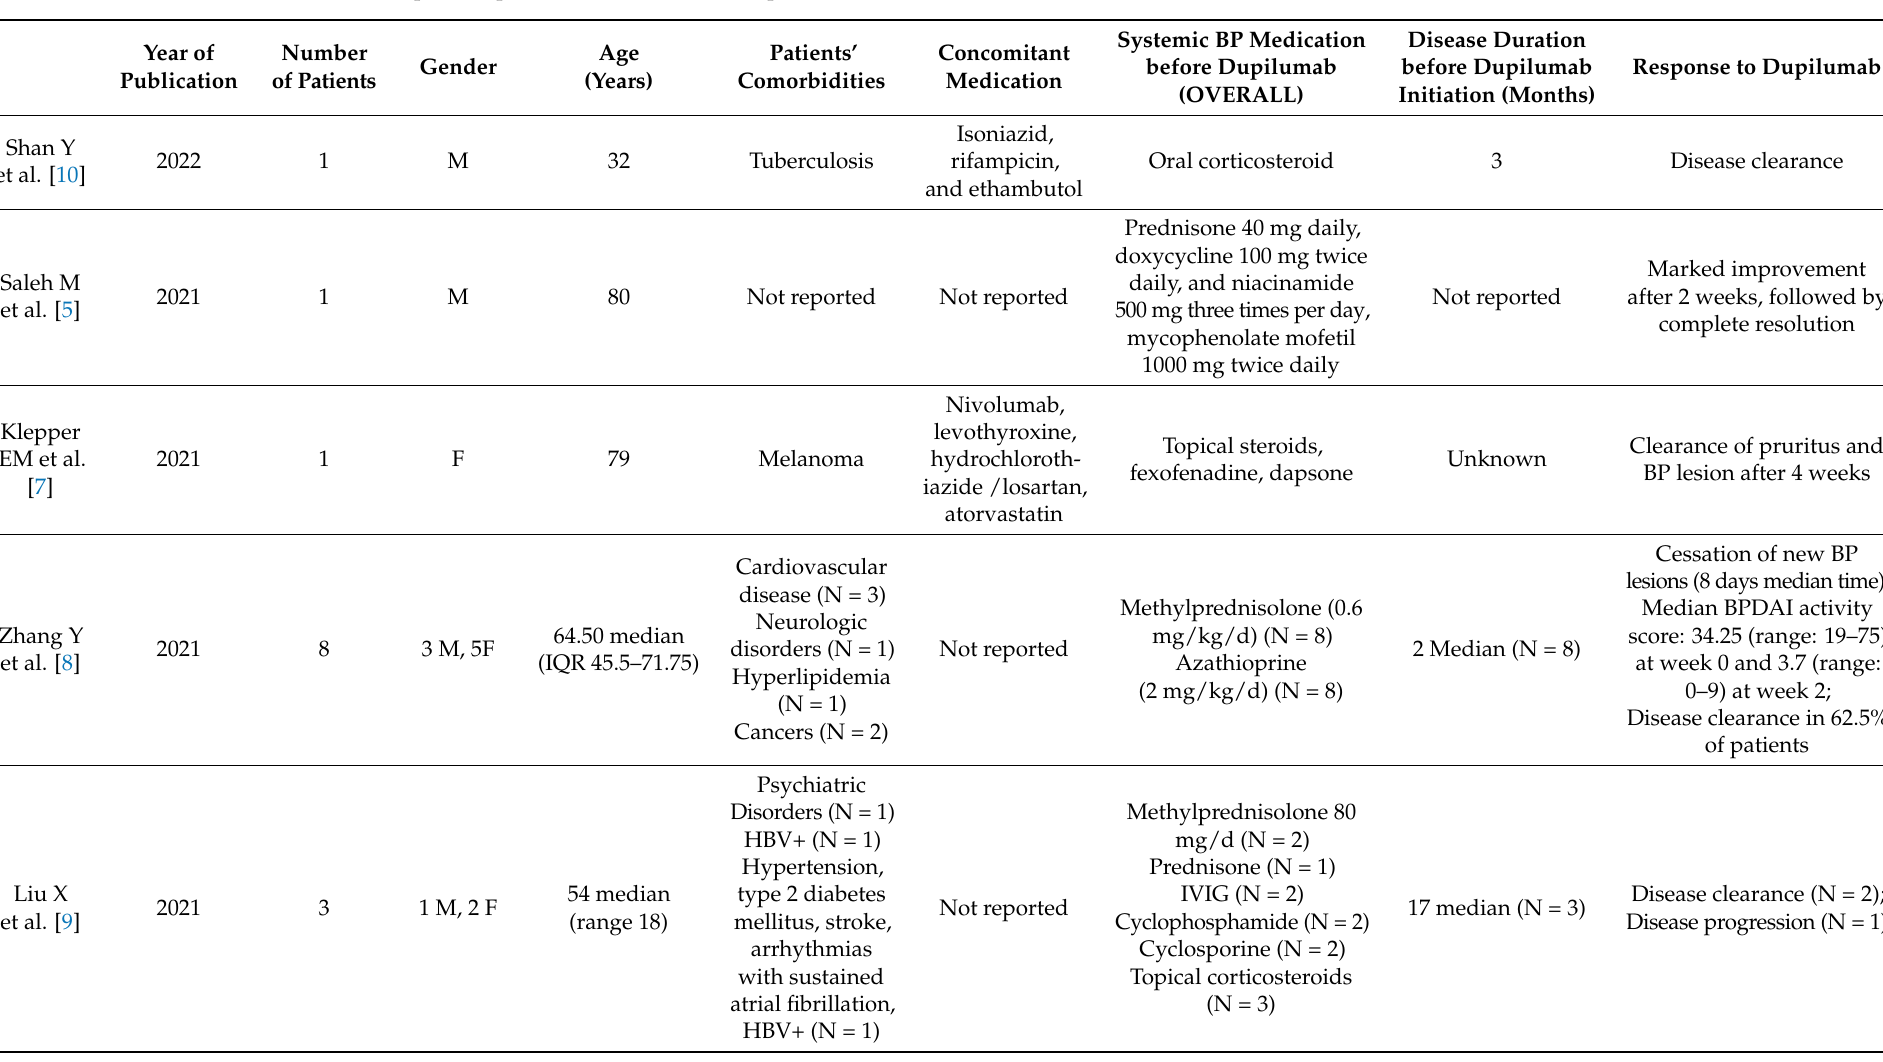
Table 1. Reports of patients BP treated with